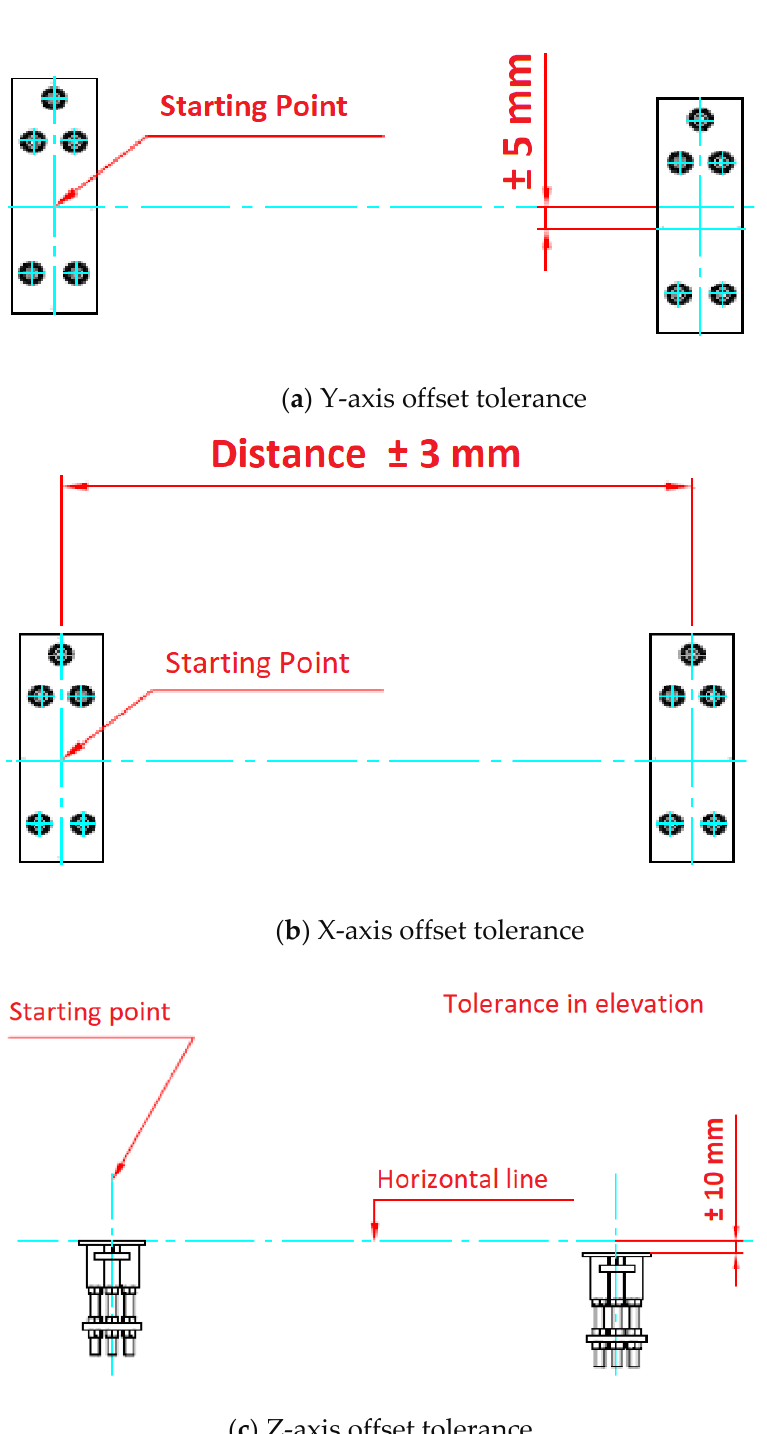
Figure 17. Comparison between BIM and point cloud data. Researchers examined the distance and the offset of the three axes between the center point of the anchor plate. The required center to center distance is 3000 mm. The actual distance is 3003 mm with −3 mm on the X -axis, 3 mm on the Y -axis, and 2 mm on the Z -axis. All of them met the quality requirement, as shown in Table 3. Table 4 shows the deviation of the control points to determine the torsion quality. The most significant deviation is 5 mm on the Z -axis, and it is within the requirement of ±10 mm.